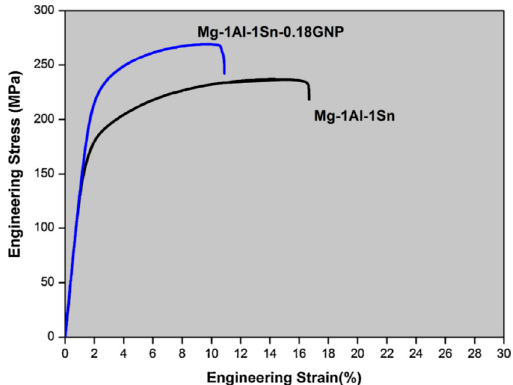
Figure 20. Tensile test of Mg-1Al-1Sn and Mg-1Al-1Sn-0.18GNP composites [1], Reproduced from [1], with permission from Elsevier, 2014.